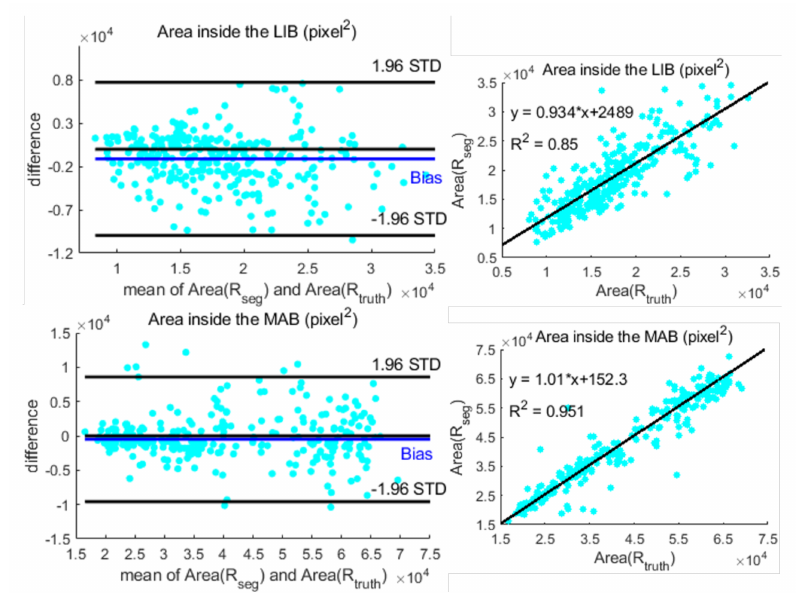
Figure 7. Bland–Altman plots (the first column) and the linear regression results (in the second column) for the comparison of areas inside the border detected by the proposed method and the ground truth.